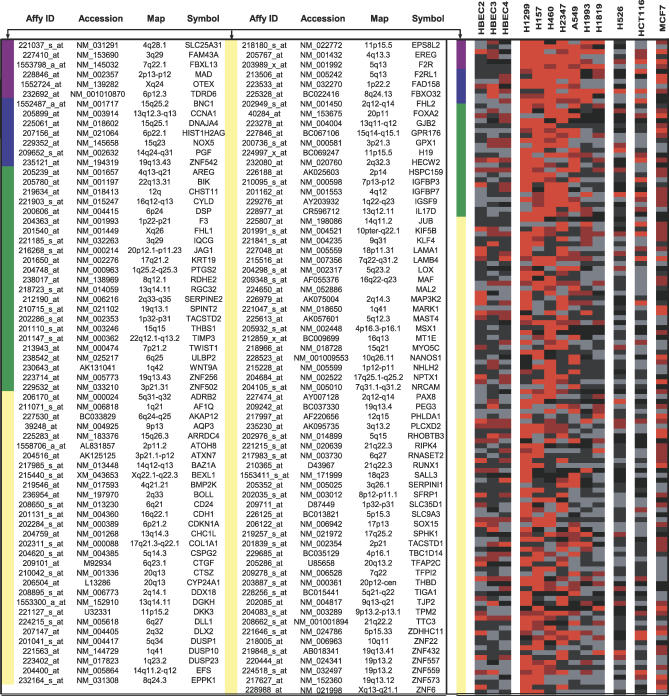
5-Aza-Induced Gene Set in NSCLC, SCLC, Breast, and Colon Cancer Cell LinesHeat map for gene induction across NSCLC and other cancer cell lines as indicated. Data are log2 changes between mock-treated and 1 μM 5-aza treatment in each cell line. Bright red indicates 4-fold or greater up-regulation; intermediate red, at least 2-fold induction; grey, less than 2-fold induction; black, no data. The data are ordered from top to bottom according to the frequency of 4-fold induction across the NSCLC cell lines. The vertical colored bars parallel to the heat map represent the frequency of 4-fold induction in the NSCLC 5-aza induction experiments. Affymetrix probe IDs, GenBank accessions, UCSC cytoband alignment, and gene symbols are represented in order from top to bottom with the colored bars from the heat map indicating fold induction; purple indicates five of seven, blue indicates four of seven, green indicates three of seven, and yellow indicates two of seven. The figure layout was borrowed from [66].